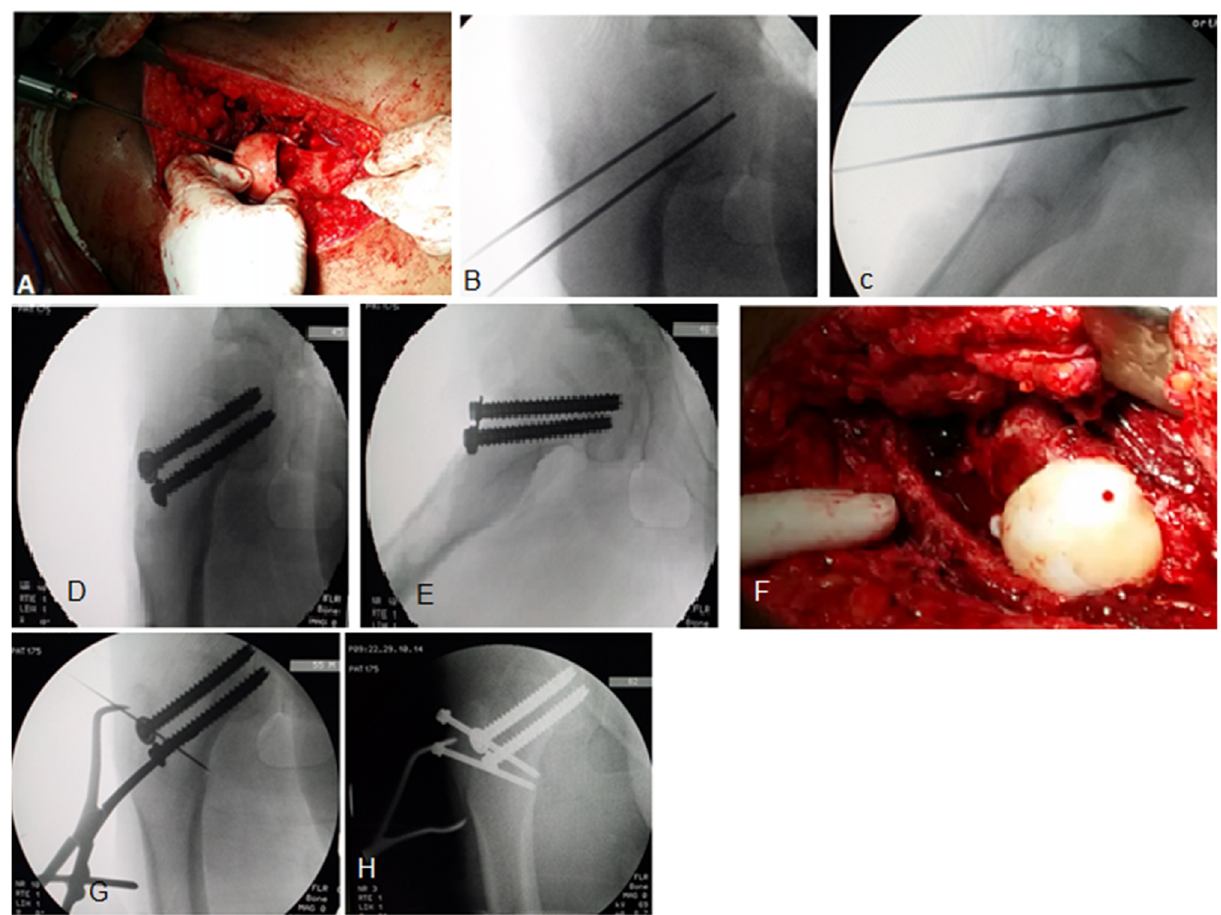
Figure 3. Intra-operative photograph (A) and the fluoroscopy images (B–E) were taken to ensure correct positioning and definitive fixation with two cancellous fully threaded screws, with bleeding head after definitive fixation (F), with reduction and fixation of the trochanteric osteotomy (G and H) in patient No. 9.